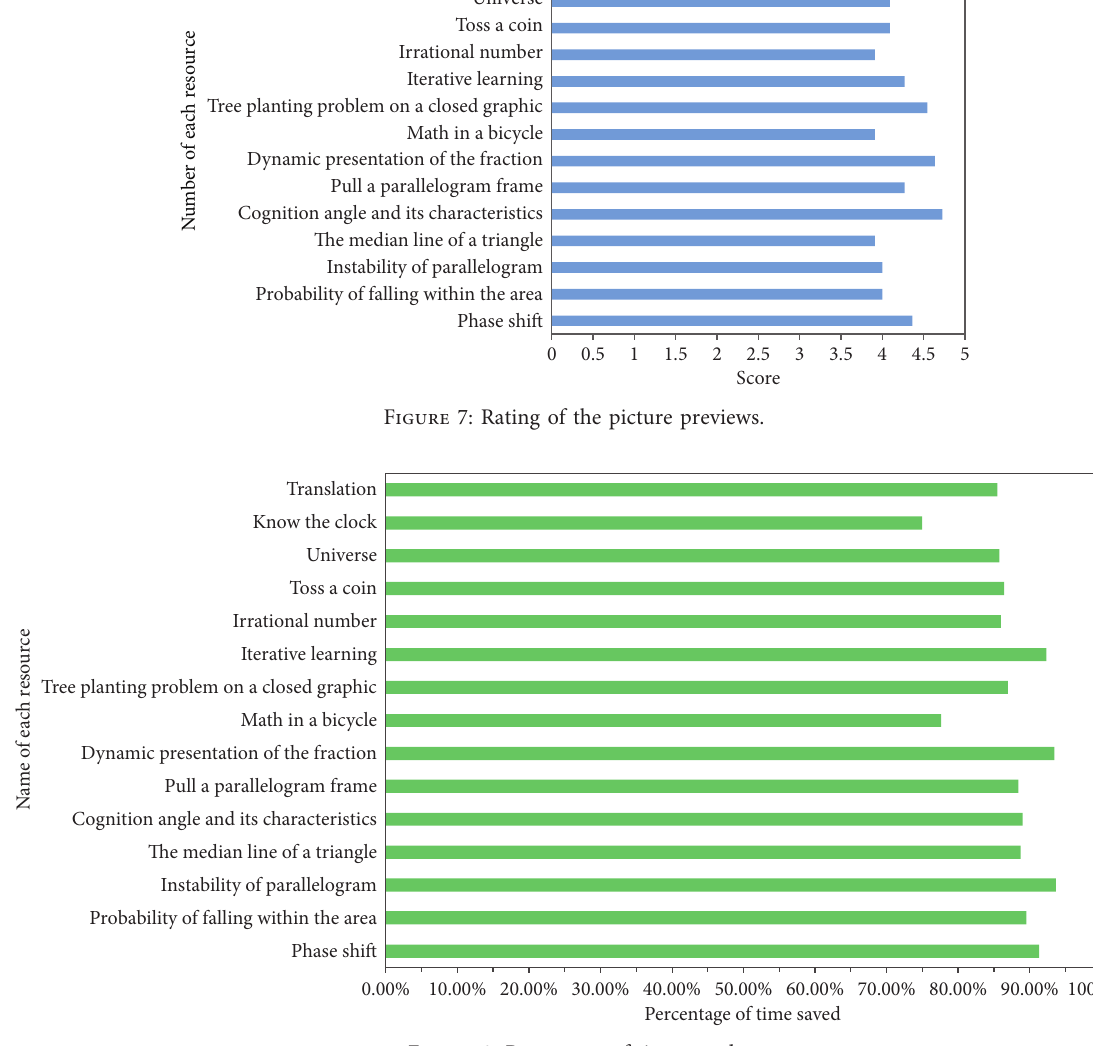
Figure 8: Percentage of time